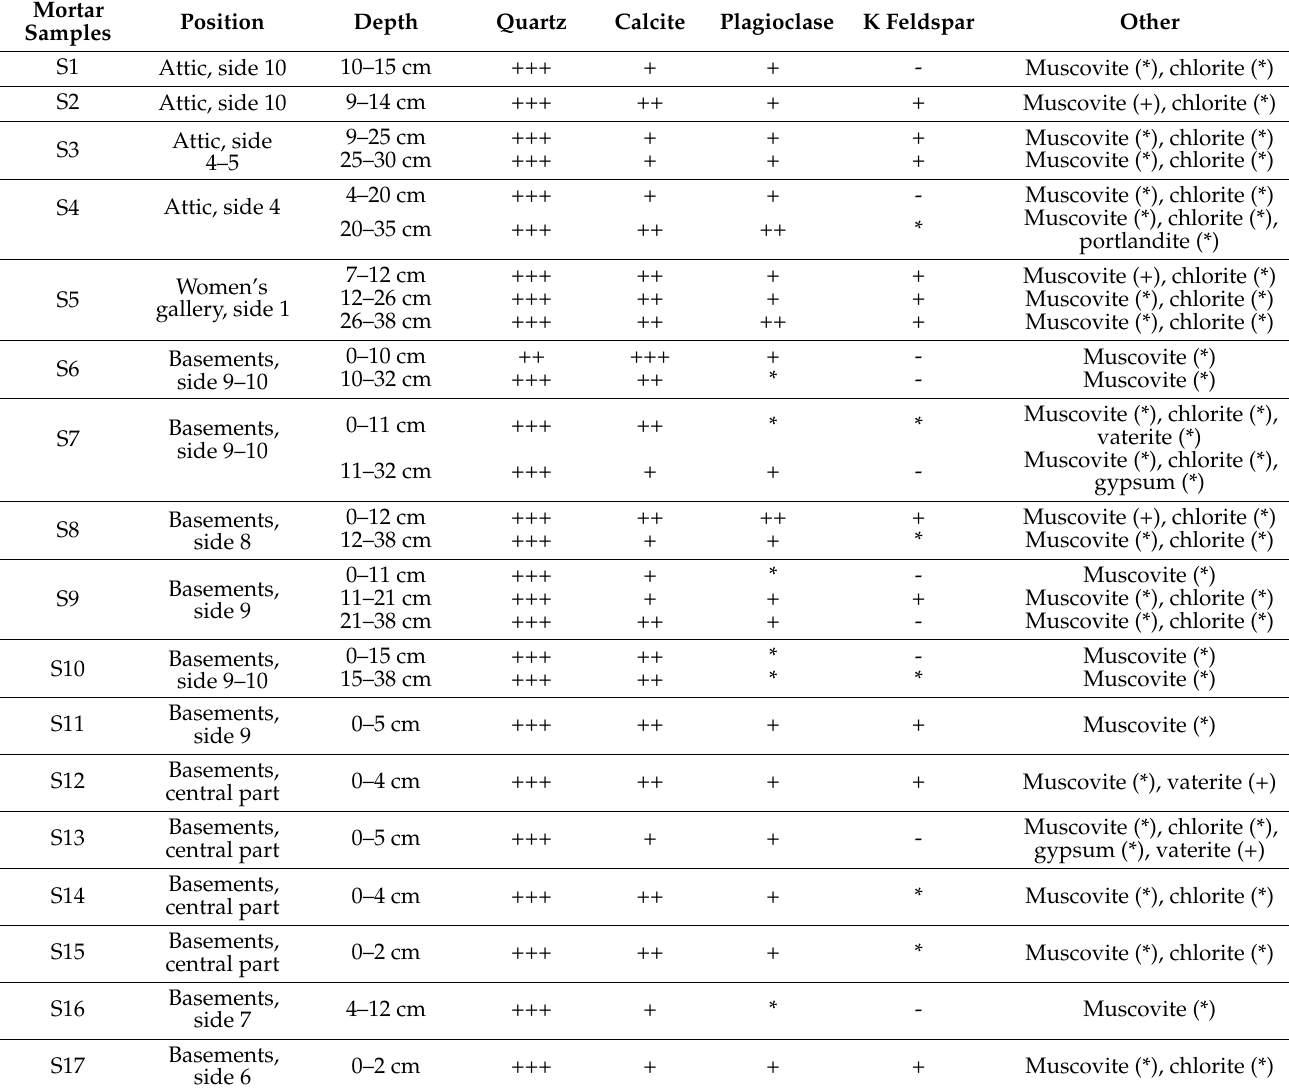
Table 3. Mineralogical composition (semiquantitative data) of mortars.